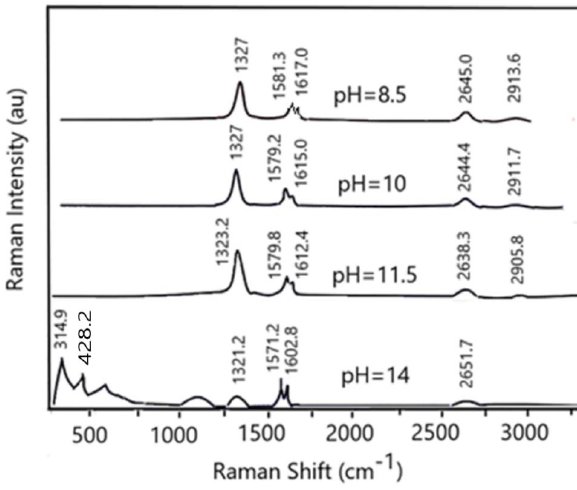
Figure 8: Raman spectra of ZnO-1.4wt% Graphene hybrids after dry- ing process in air at 150 ∘ C, for different pH values during synthesis.